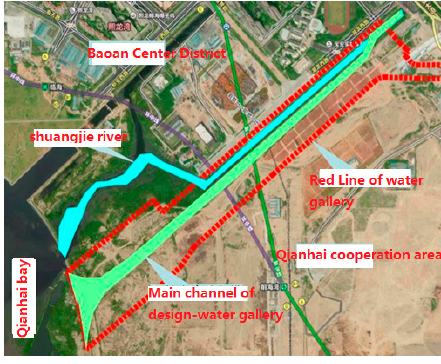
Figure 1. Layout of the main channel of the waterway.